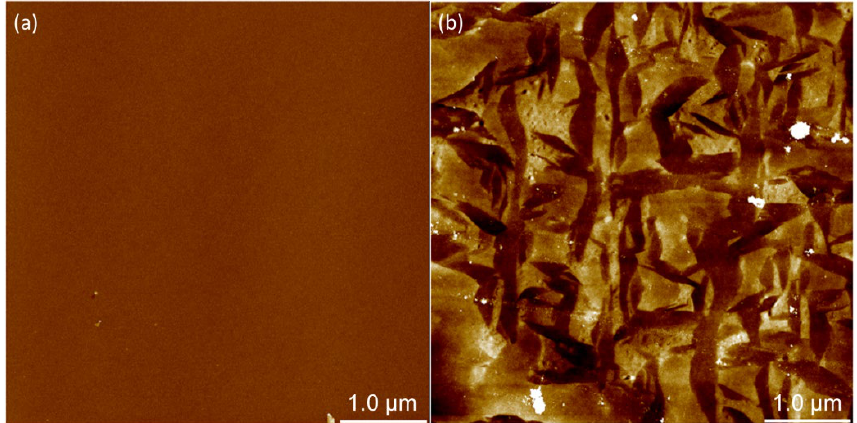
Figure 2. AFM images (5 μm × 5 μm) of ( a ) Si substrate and ( b ) Ti substrate surfaces. Higher areas are represented by lighter colours. Maximal value of the z -axis is 5 nm.